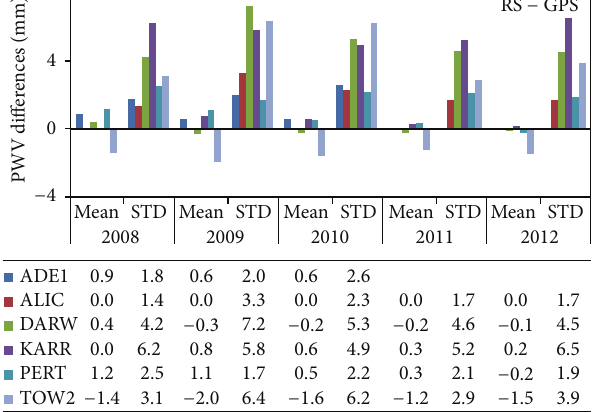
Figure 6: Comparison between radiosonde measurements of PWV (mm) and GPS for 2008–2012.